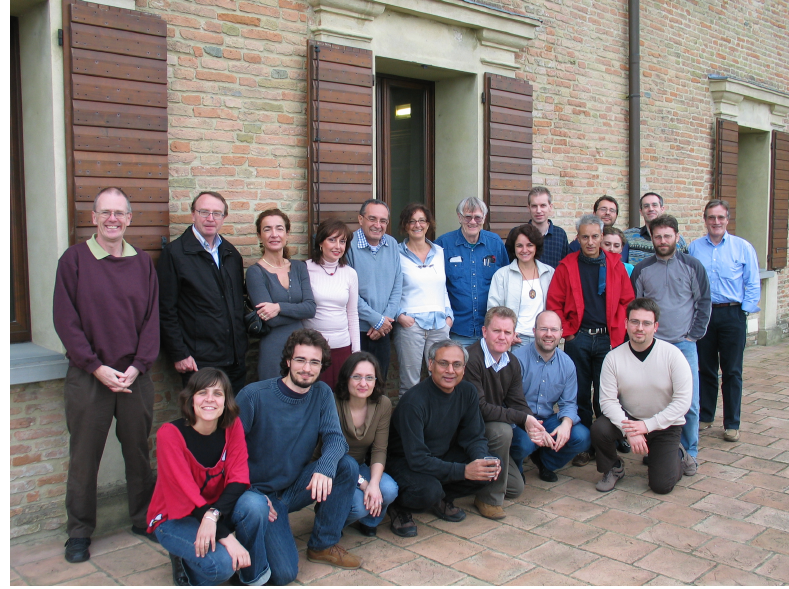
Figure 1 – "Workshop on Skew Symmetric Probability Distributions", Bertinoro, 2008. Among others, the participants in the picture are: Glòria Mateu-Figueras, Antonio Canale, Simona Pacillo, Narayanaswamy Balakrishnan, Arthur Pewsey, Bruno Scarpa, Márcia D’Elia Branco, Reinaldo Arellano Valle, Claudio Agostinelli (bottom row, kneeled, left to right), M. Chris Jones, Adelchi Azzalini, Antonella Capitanio, Anna Clara Monti, Heleno Bolfarine, Elena Stanghellini, Barry Arnold, Marc Genton, Andrea Tancredi, Nicola Loperfido, Chris J. Adcock (back row,